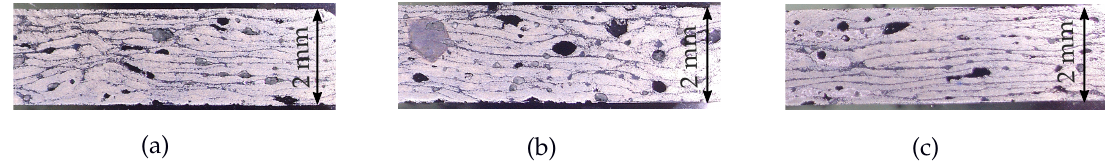
Figure 7. Microscope images of the laminate structure. ( a ) Laminate without gaps; ( b ) Laminate with gaps; ( c ) Laminate with printed